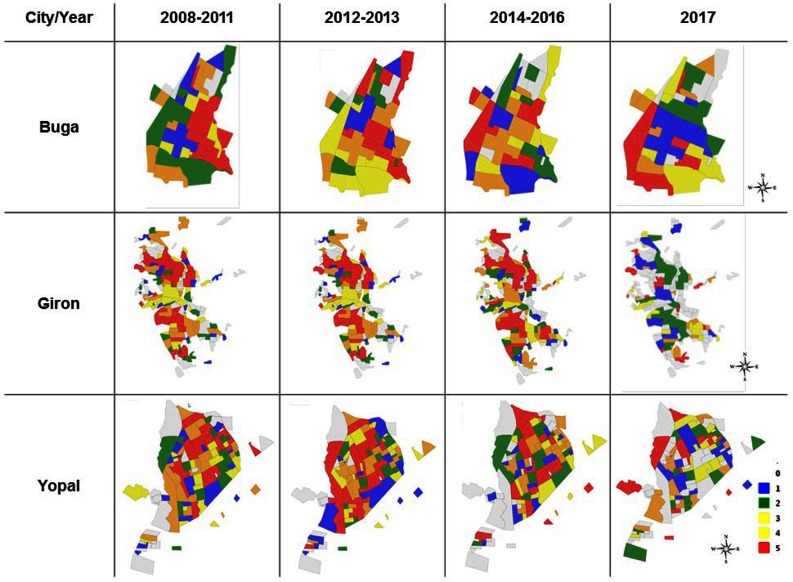
Trends in the Quintiles of the Dengue Epidemiological Risk Component in Buga, Giron, and Yopal, Colombia, 2008–2017Maps of quintiles of risk stratification, with 1 (blue) being the lowest and 5 (red) being the highest. 0 indicates missing data.